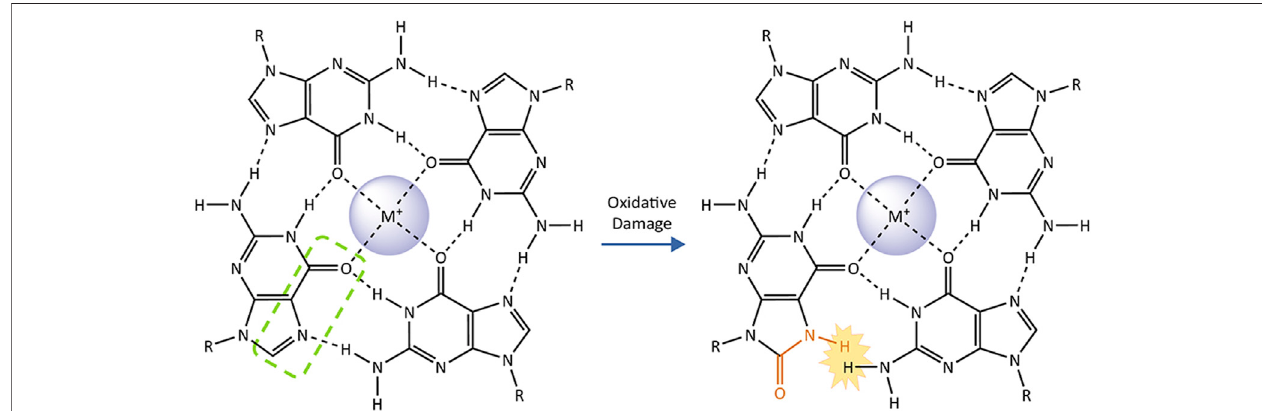
FIGURE4| Theimpact of8-oxoguanineonaG-quartet. G-quadruplexes consistoftwoormorestackedG-quartetsand central monovalentcations. Theseplanar arrangements of four guanine bases are stabilized by hydrogen bonding on their Hoogsteen face (highlighted by green dashed line on one representative base). Conversion of the guanine to 8-oxoguanine (affected atoms and bonds in orange) introduces a steric clash with the adjacent guanine that prevents them from forming a Hoogsteen binding interaction, destabilizing the G-quartet and the G-quadruplex as a whole.